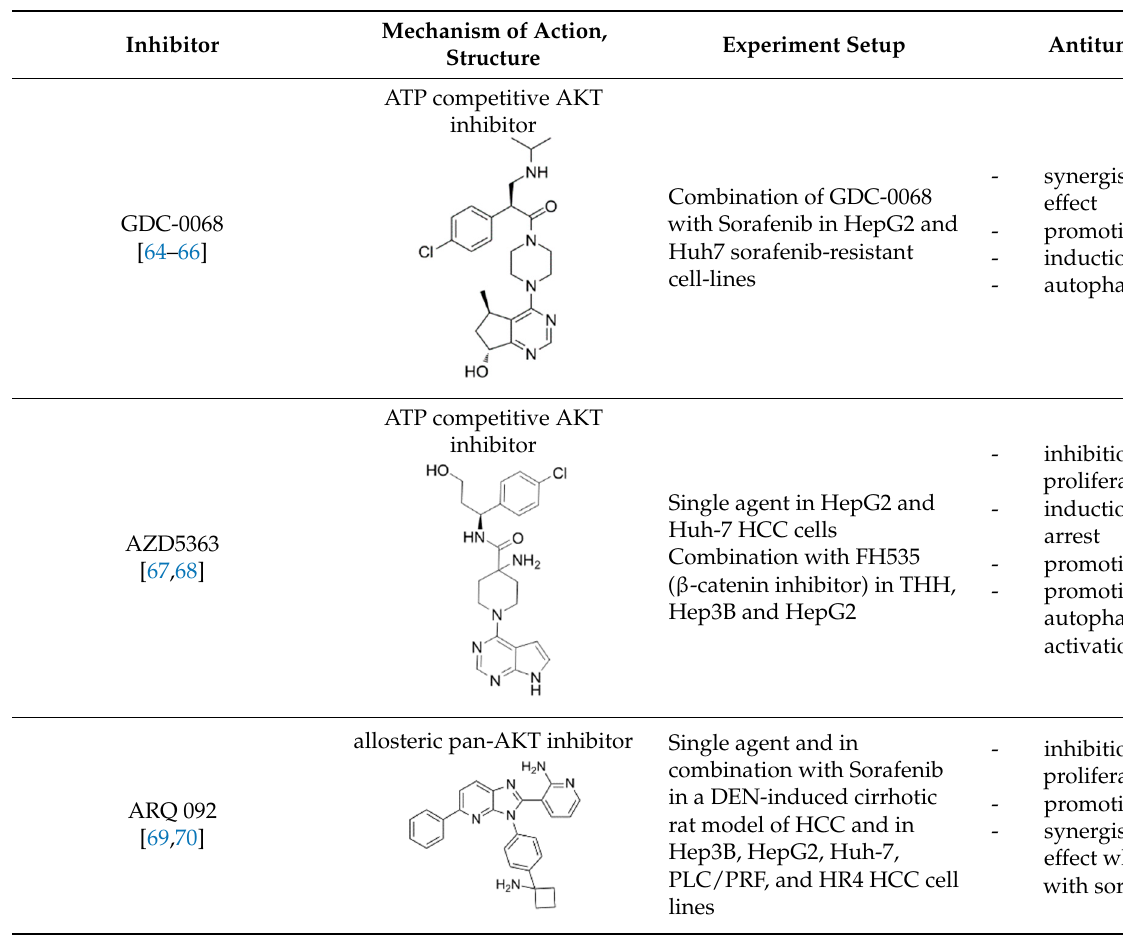
Table 1. Akt inhibitors in the management of HCC.